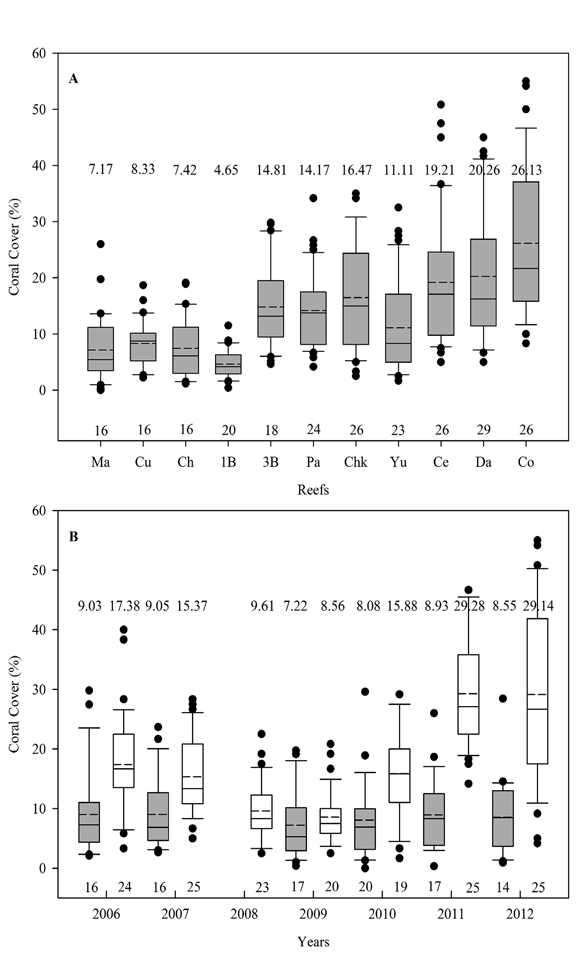
Fig. 2. – Box plot of live coral cover by reef site (A) and year (B) for Cancún and Cozumel. The solid line in the box represents the me- dian; the dotted line represents the average. The bottom and top bars in the boxes represent the 25 th and 75 th percentiles; whiskers above and below the box are the 10 th and 90 th percentiles, respectively. The dots represent the outliers. The numbers above the boxes are the values of the average coral cover and the base the total number of